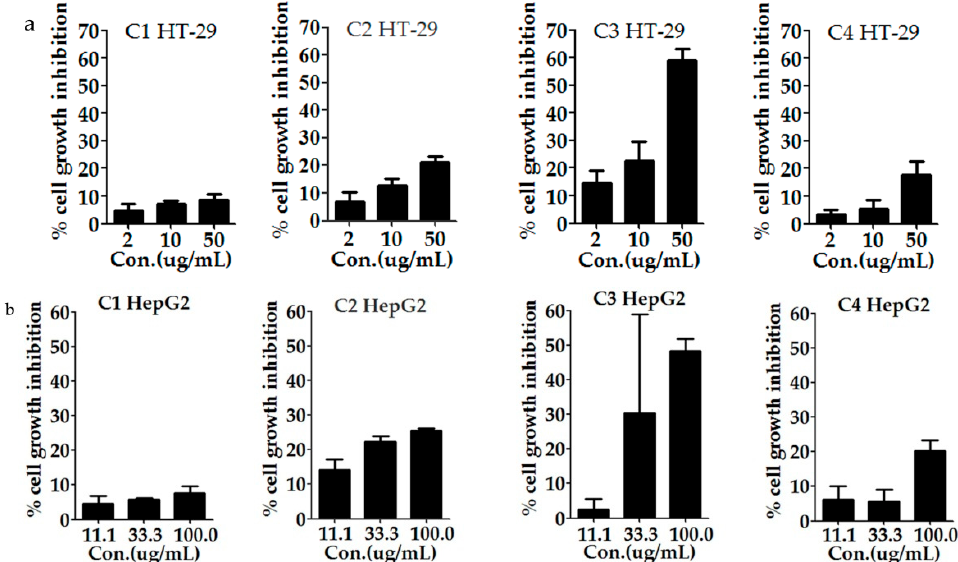
Figure 8. Anti-proliferative activity of some compounds from the EA fraction of H. abyssinica , C1 = dihydroquercetin, C2 = acacetin, C3 = quercetin, and C4 = isoquercitin. ( a ) The inhibition ratio of HT-29 treated by compounds C1–C4 of H. abyssinica . ( b ) The inhibition ratio of HepG2 treated by compounds C1–C4 of H. abyssinica . All of the values in the figure are expressed as means (%) and standard deviation of triplicated experiments.